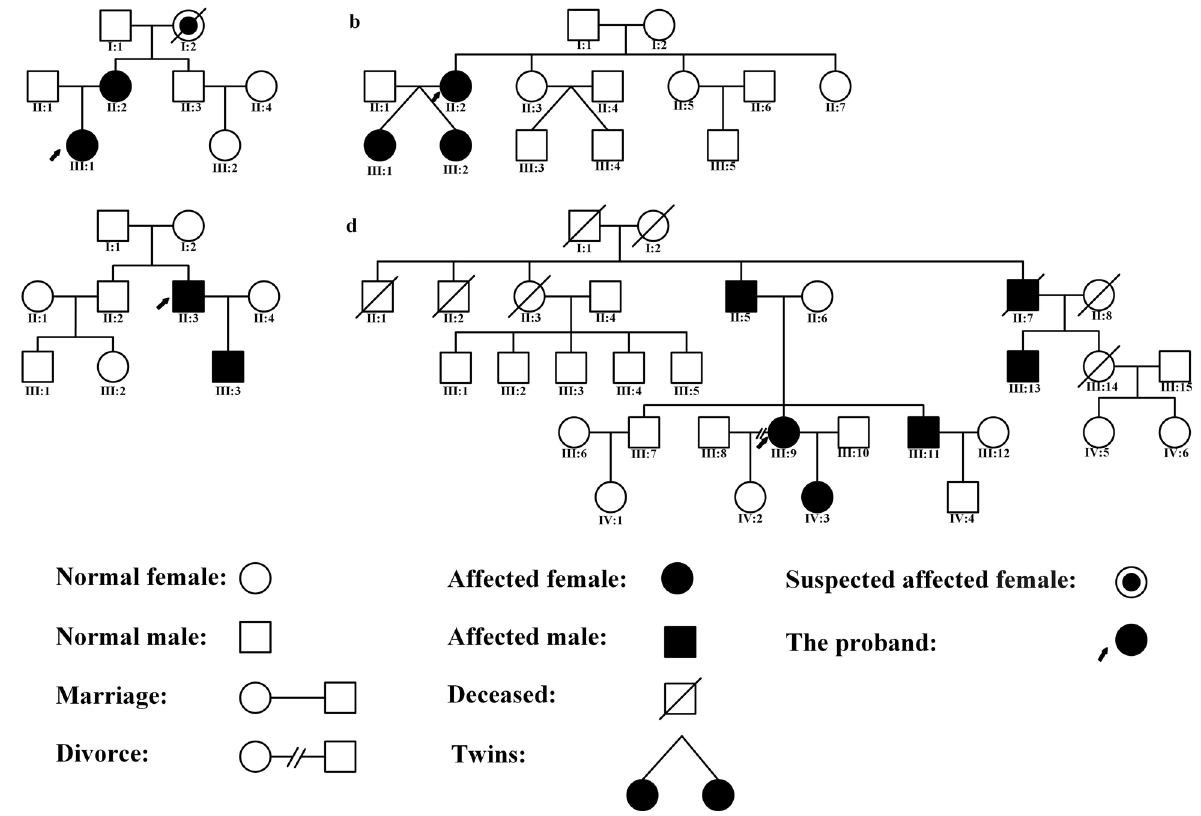
Figure 1. The pedigree charts of patients 3 ( a ), 5 ( b ), 6 ( c ), and 7 ( d